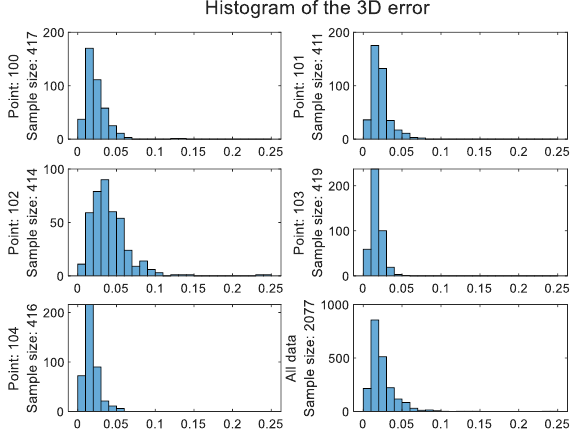
Figure 7. Histograms of 3D errors for the single points and for all the measurements